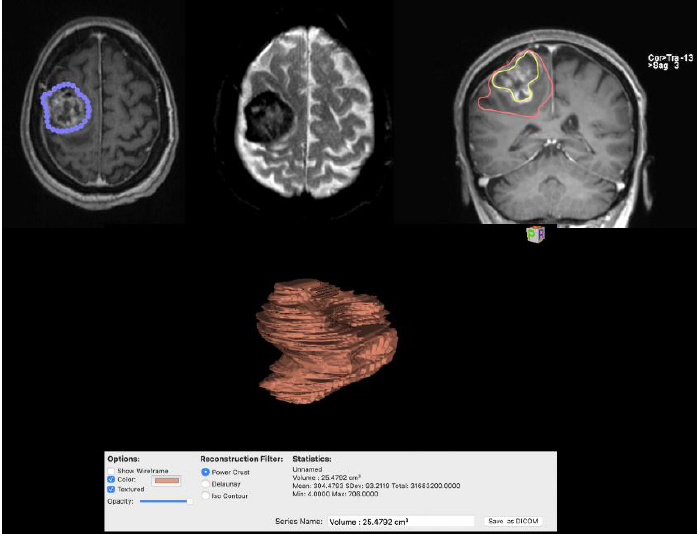
Figure 1. Images show calculation of edema volumes and contrast-capturing lesion with 3D recon- struction of the tumor obtained with Osirix software.